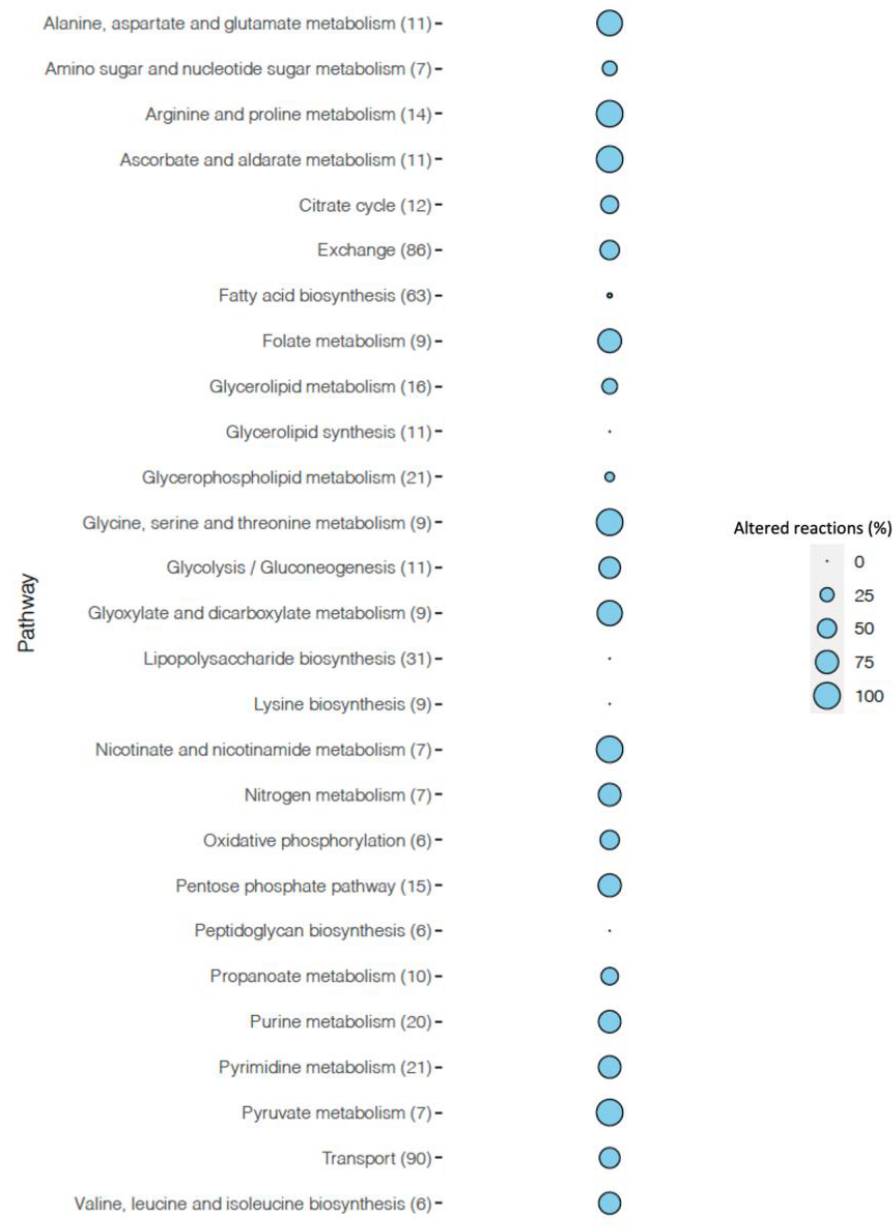
Figure 3. Balloon plot represents the percentage of altered reactions in pathways when transition from exponential phase to biofilm